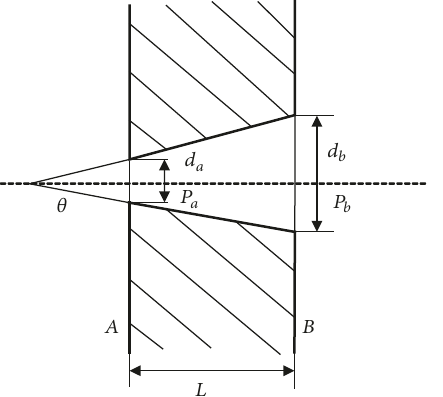
Figure 9: Structure chart of the plane cone tube.